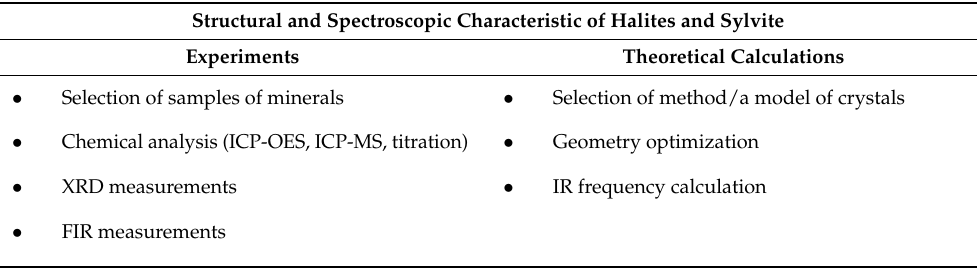
Table 1. List of experimental and theoretical studies carried out in this work.